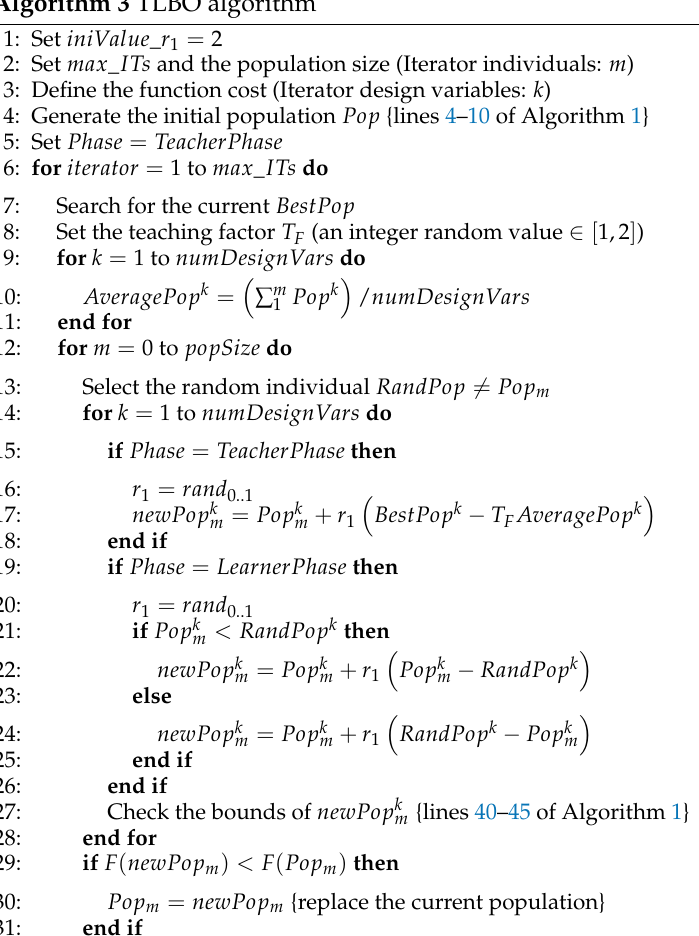
Algorithm 3 TLBO algorithm